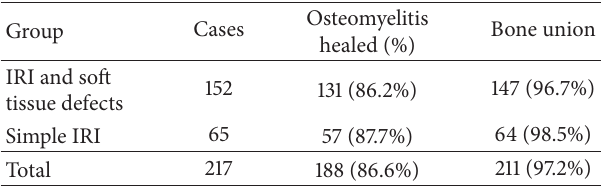
Table 1: The treatment results of 217 cases of IRI in the